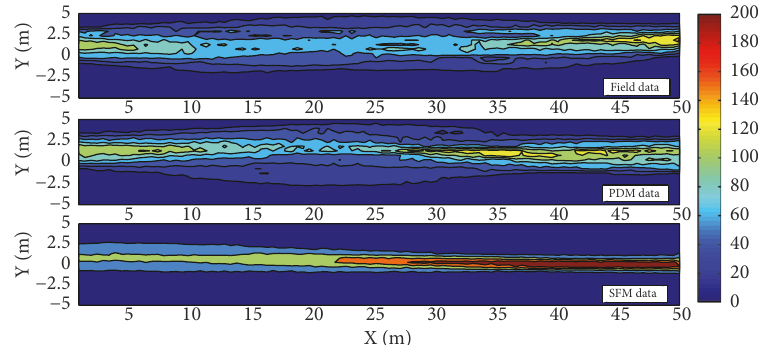
Figure 19: Distribution of nonmotorized vehicles at the Xianxia-Jianhe intersection.